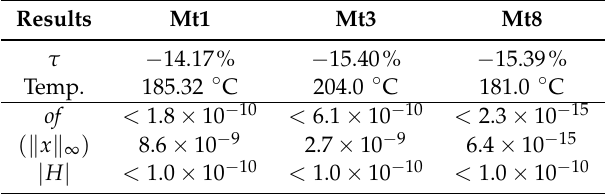
Table 9. Optimization results for NO 2 and three material types Mt i ; i = 1, 3, 8.